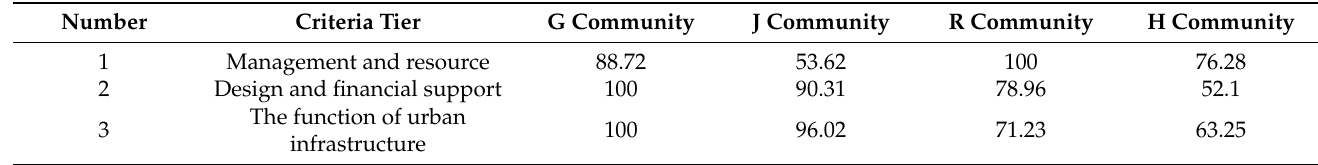
Table 7. Final comparison results on the comprehensive assessment of relative